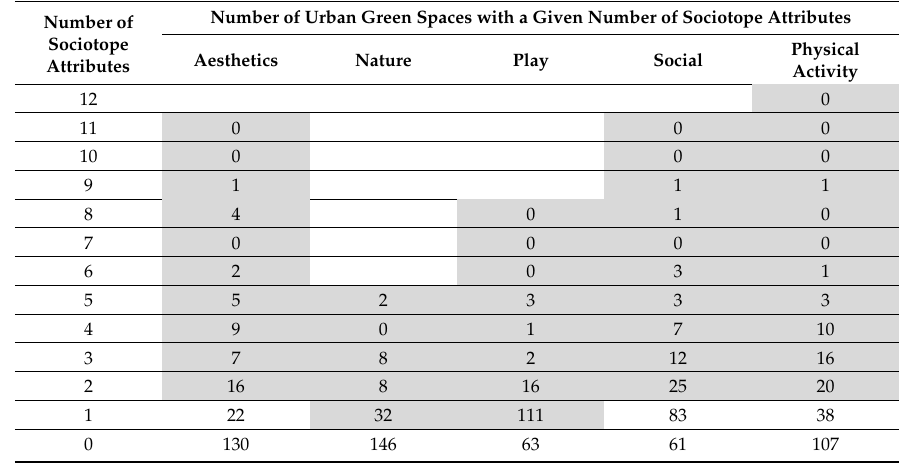
Table 2. The synthesis of sociotope attributes for urban green spaces in Lodz. Shaded cells represent the number of sociotope attributes required to assign a given urban green space to a respective main sociotope category. For example, a green space is assigned to the sociotope category “aesthetics” if there are two, three, or more (up to eleven) sociotope attributes located within such a green space. The zero value means there could be the given number of sociotope attributes, but it was not observed in any green